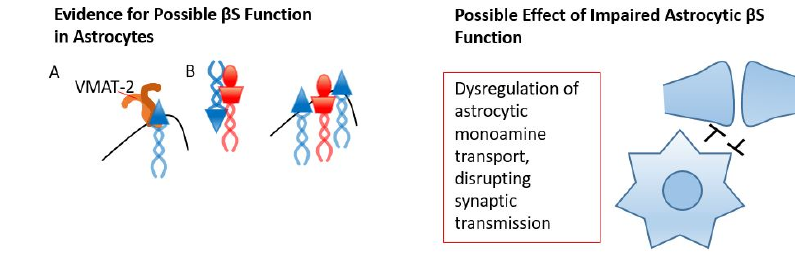
Figure 2. β S only contains 6 repeated sequences with the consensus of KTKEGV in the N-terminus. β S’s calcium-binding C-terminus is also responsible for the inhibition of α S aggregation by interacting with the N-terminus of α S. In A, it has been shown in neurons that β S facilitates monoamine transport through VMAT-2, which would likely result in this function in astrocytes. In B, β S inhibits detrimental α S aggregation through two methods, the C-terminus region binding with the α S N-terminus to form heterodimers and inhibit aggregation, and β S competing with α S for membrane binding. The likely effect of impaired β S functioning in astrocytes would be dysregulation of astrocytic monoamine transport from the synapse and within the astrocyte for release.